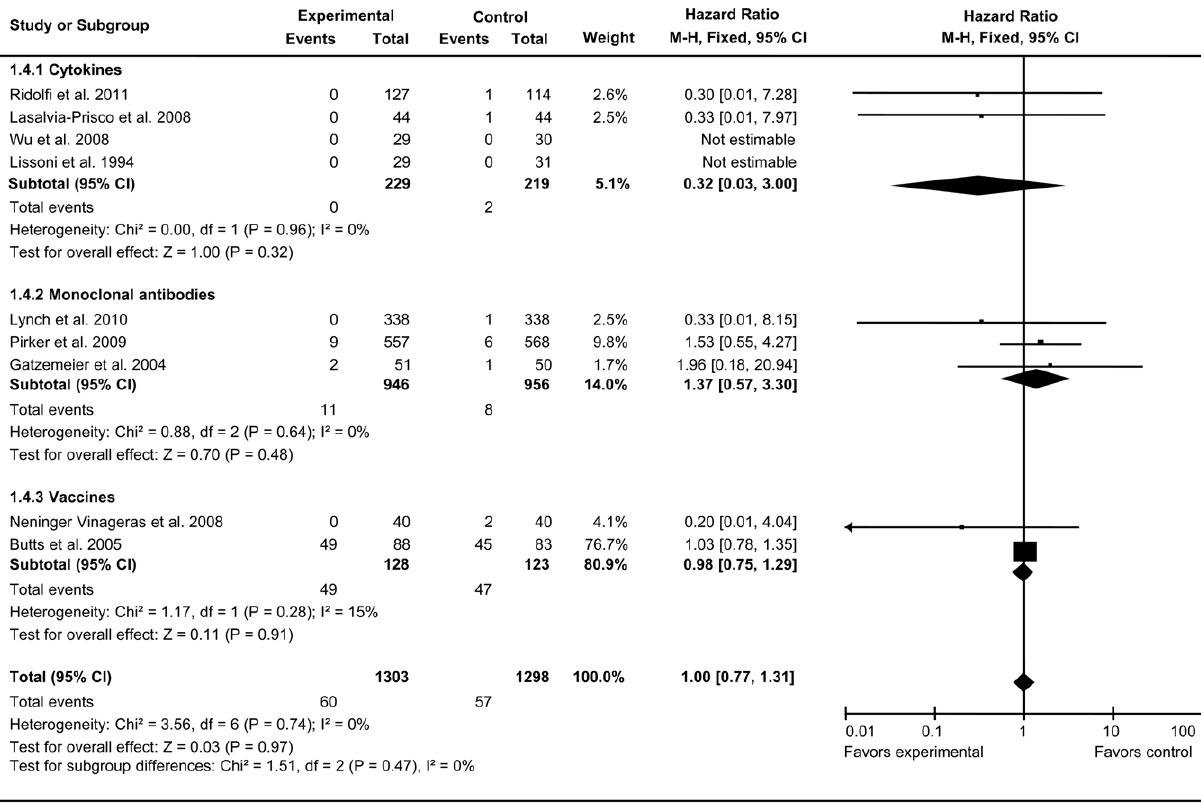
Table 3. Sensitivity analysis for the outcome of studies not using chemotherapy*.